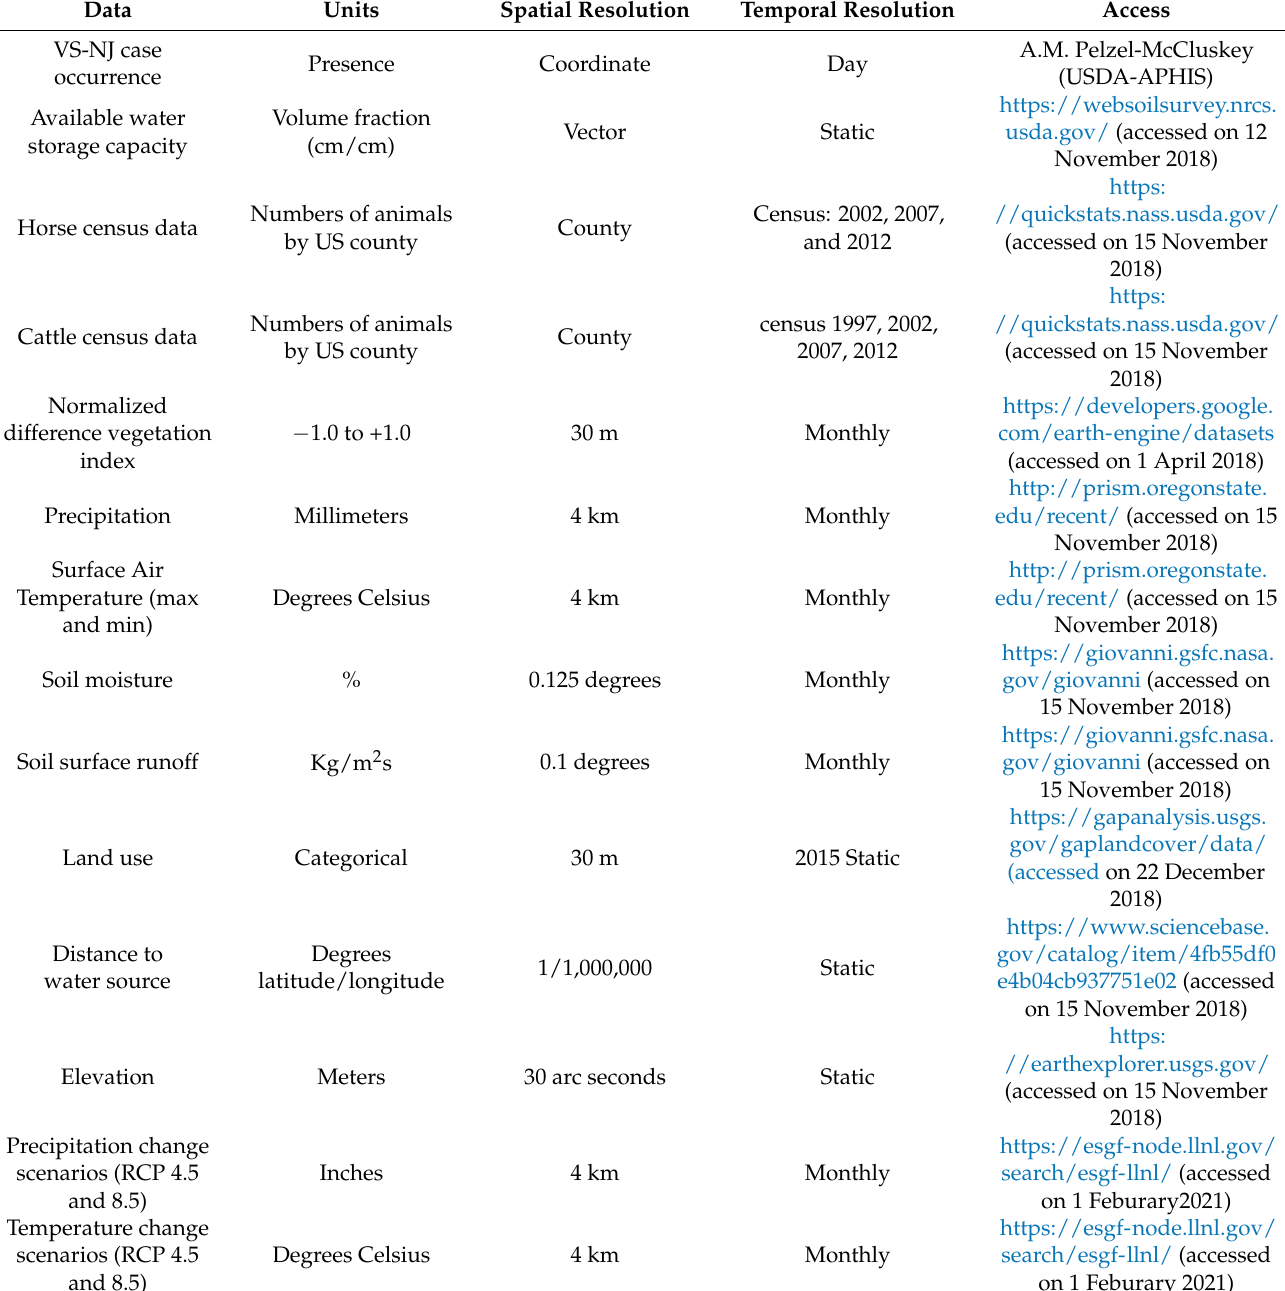
Table 1. The units, spatial and temporal resolution, and source location of environmental data used to create the 34 variables considered in this analysis. See Sections 2.3 and 2.4 for details on how variables were processed from these